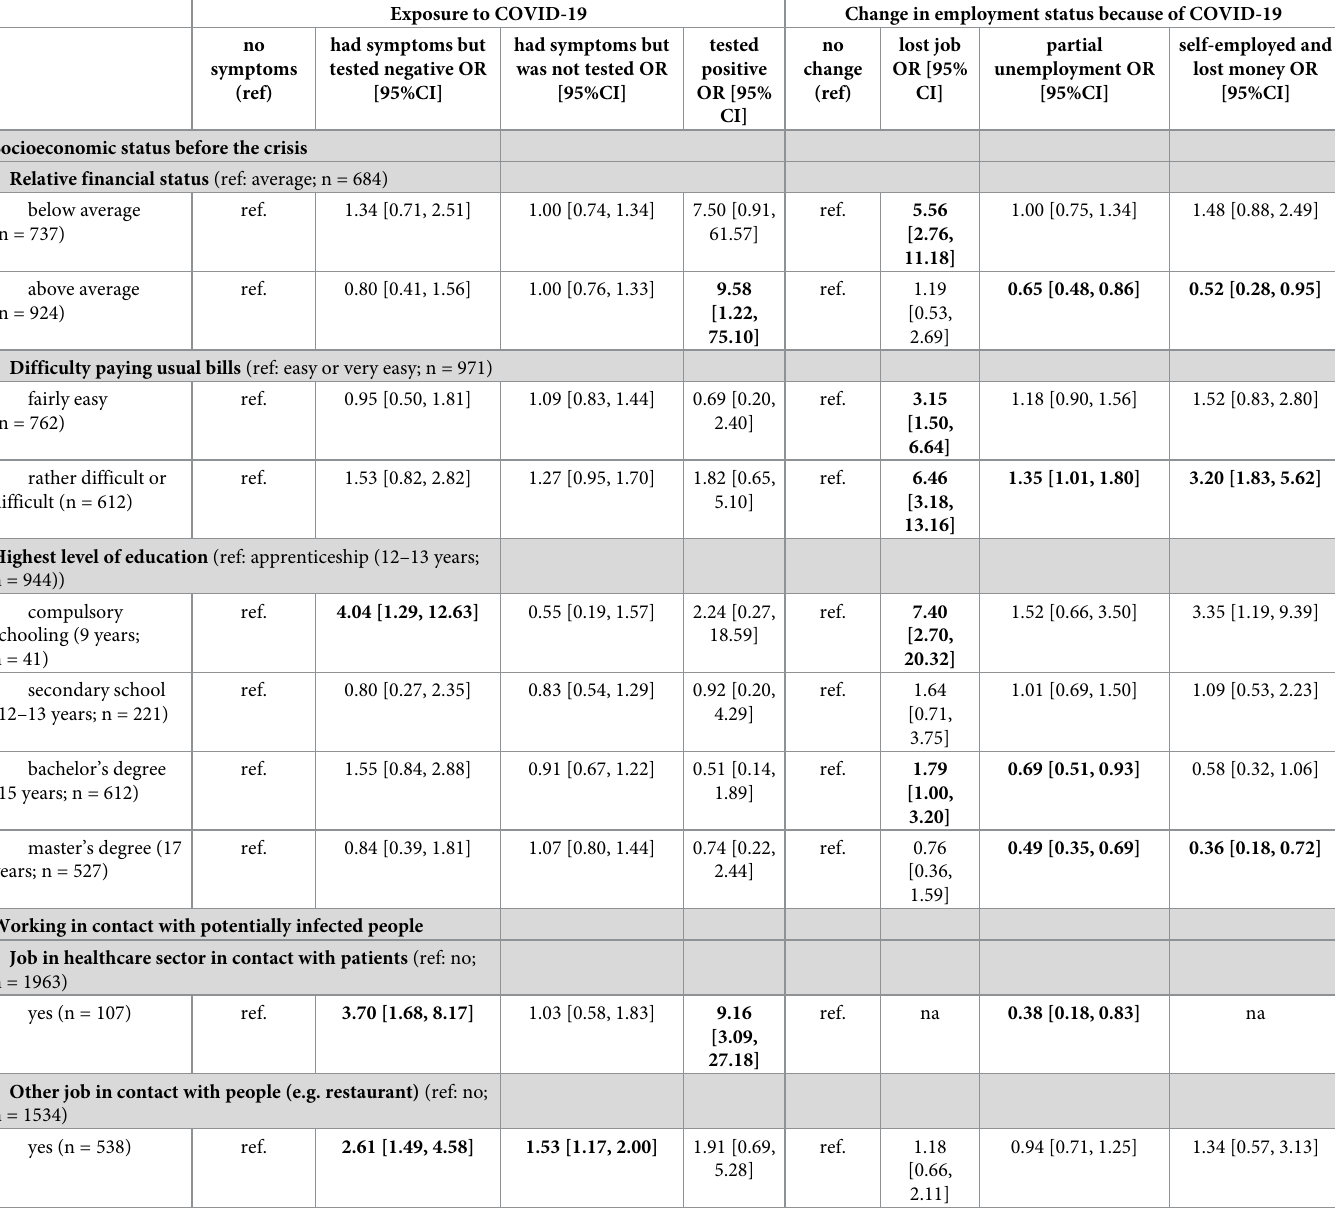
Table 3. Results of multinomial regressions testing associations between experiences of COVID-19 symptoms and change in employment status, with socioeco- nomic status, highest level of education and working in contact with potentially infected people. Exposure to